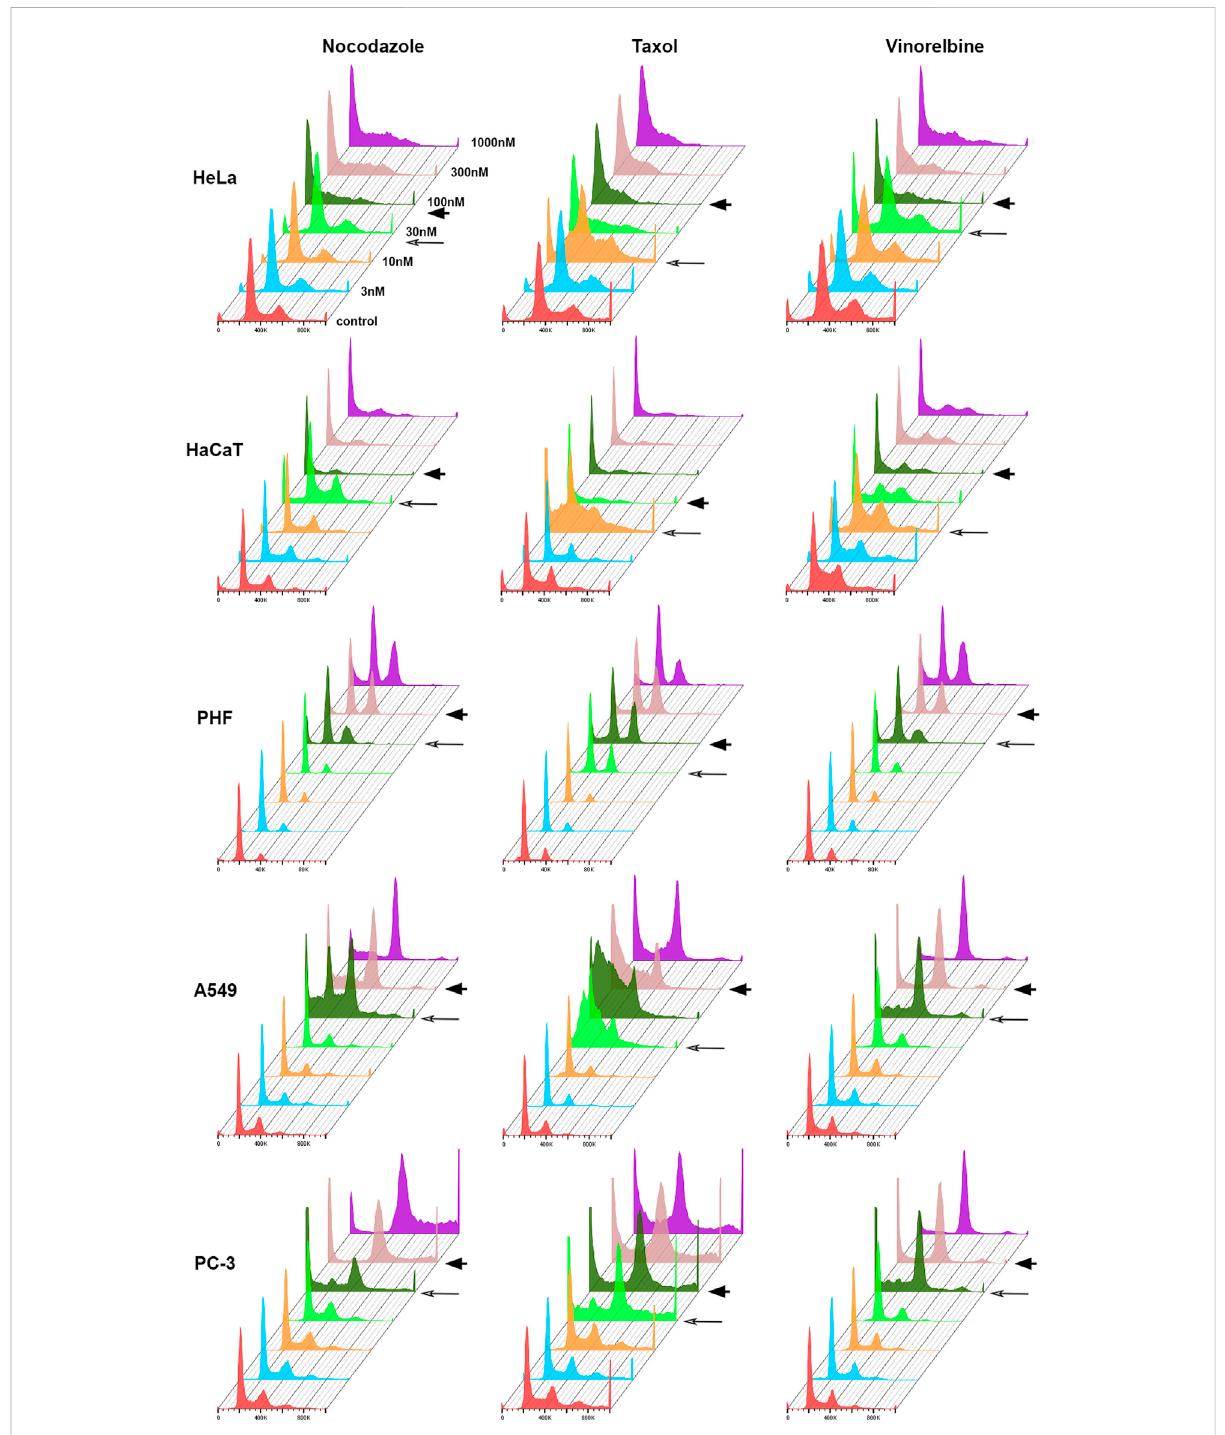
FIGURE 1 Histograms showing cell distribution according to DNA content after 48 h treatment with anti-microtubule drugs. Minimal threshold concentrations (T1) for each drug are indicated by long arrow, and maximal threshold concentrations (T2) — by arrowhead.